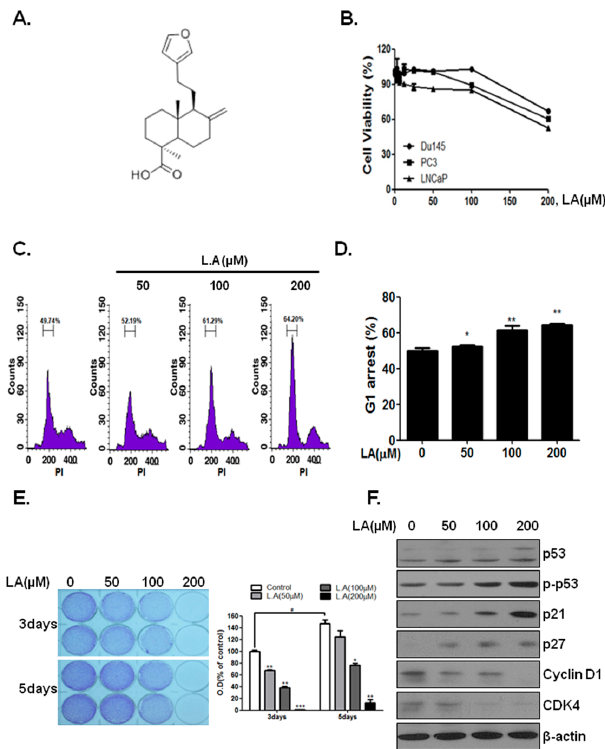
Figure 1. Effect of LA on induced G 1 arrest and proliferation after 24 h of incubation with LNCaP cells. ( A ) Chemical structure of LA; ( B ) Cytotoxicity of LA against prostate cancer cells was determined by the MTT assay. Cells were treated with various concentrations of LA (0, 3.125, 6.25, 12.5, 25, 50, 100 and 200 µ M) for 24 h; ( C ) LNCaP cells were treated with LA (0, 50, 100 and 200 µ M) for 24 h and stained with propidium iodide (PI) after fixation. Stained cells were analyzed using a FACS Vantage flow cytometry system; ( D ) G 1 arrest (%) in LA-treated cell after 24 h. * p < 0.05 and ** p < 0.01 (in comparison to the control); ( E ) Anti-proliferative activity of LA was evaluated using the cell growth assay. LNCaP cells were treated with LA (0, 50, 100, 200 µ M) and incubated for three and five days. Cells were stained; then, randomly chosen fields were photographed and resolved in 70% ethanol after washing with distilled water, and absorbance was read using a microplate reader. # p < 0.05, * p < 0.05, ** p < 0.01 and *** p < 0.001 (in comparison to the control); ( F ) LNCaP cells were treated with LA (0, 50, 100 and 200 µ M) for 24 h and subjected to Western blot analysis of protein levels (p-P53, P53, P21, P27, cyclin D1 and